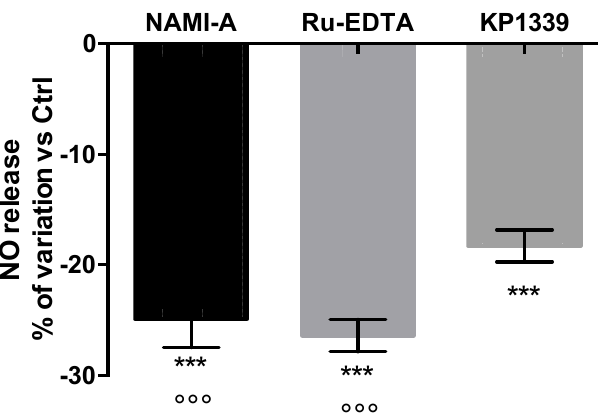
Figure 3. Effects of the pre-treatment with the ruthenium compounds on the NO production by macrophages. Murine peritoneal macrophages were treated with 10 − 4 M NAMI-A, RuEDTA, and sodium (bis-indazole)tetrachloro-ruthenate(III), Na[ trans -RuCl 4 Ind 2 ] (KP1339), then washed and further treated for 24 h with 10 μ g/mL LPS. NO release in the extracellular medium was measured by the Griess test. Data are expressed as per cent of variation vs. the controls and are the mean ± S.E.M. of five samples per group. ANOVA and Tukey–Kramer: *** p < 0.001 vs. Control; °°° p < 0.001 vs. KP1339.